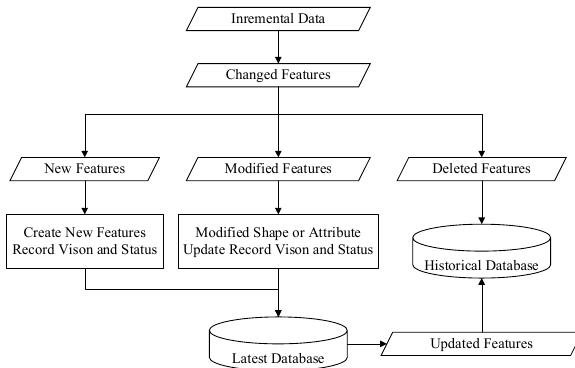
Figure 6 . Flow chart of incremental data updated into database